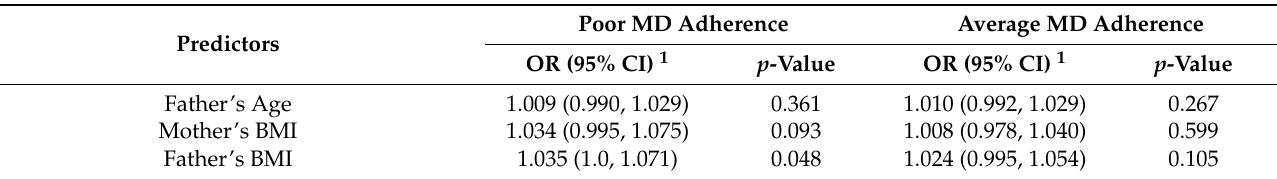
Table 2. Results of the multinomial logistic regression with categories of children MD adherence as a dependent variable and parental traits as independent